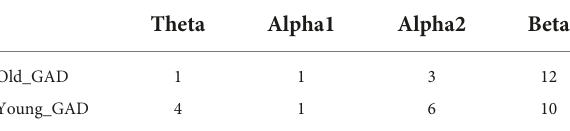
TABLE 3 Functional connectivity (FC) numbers of the Old_GAD and the Young_GAD in four rhythms.